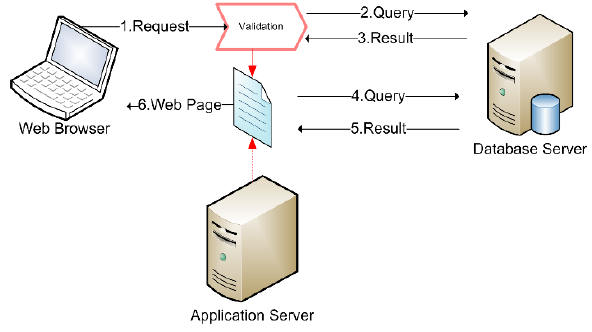
Figure 1. Architecture of